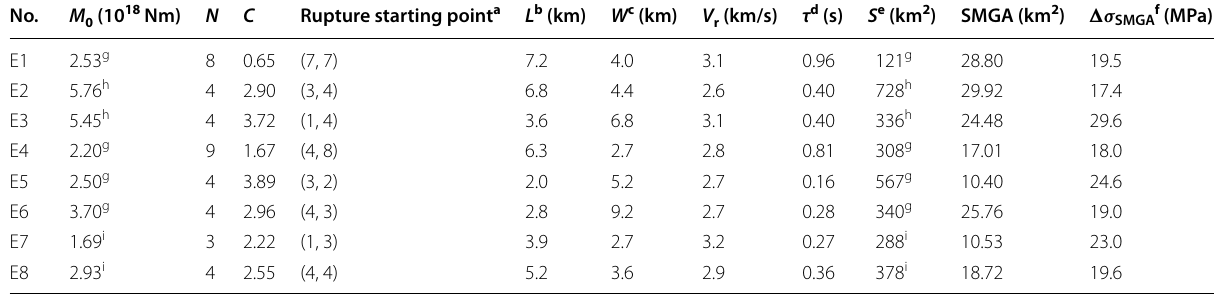
Table 2 Source parameters determined by source spectral ratio fitting analysis and strong ground motion simulation in this study